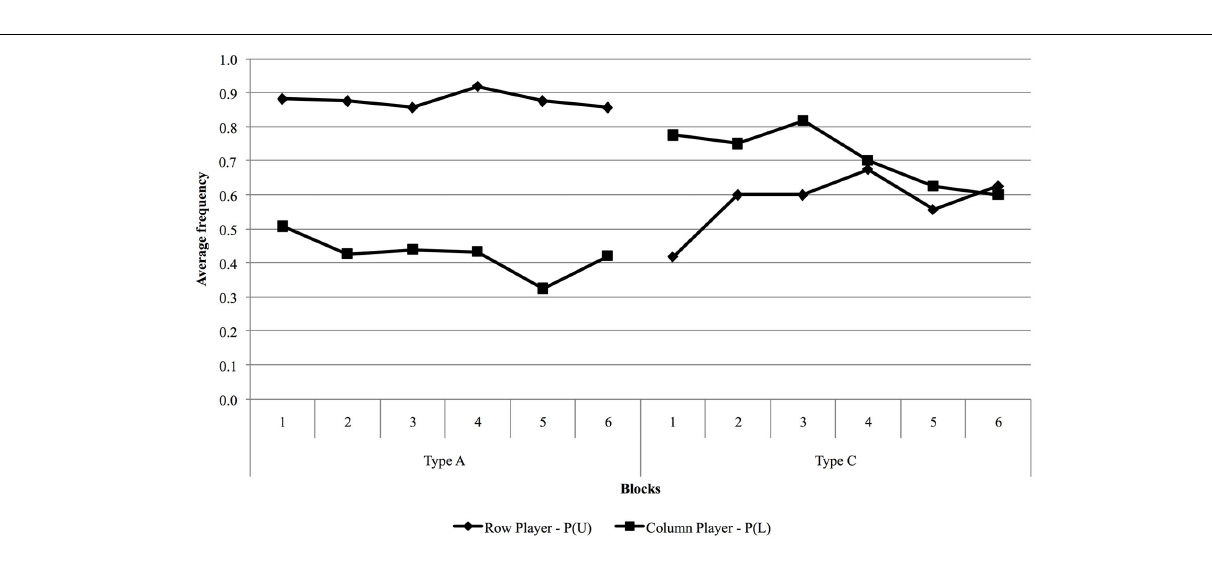
FIGURE 2 | Observed proportions of U and L choices averaged over blocks of 10 trials, separately for typeA and C